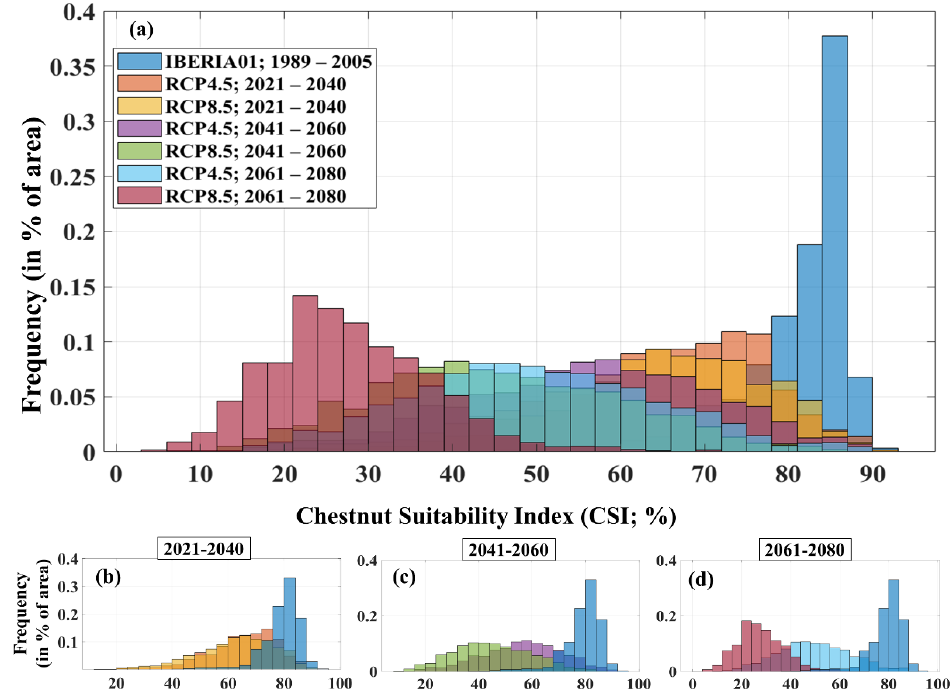
Figure 7. Relative distribution of chestnut areas (%) as a function of the CSI for ( a ) all periods (2021 – 2040; 2041 – 2060; 2061 – 2080), and each period separately ( b ) 2021 – 2040; ( c ) 2041 – 2060; ( d ) 2061 – 2080, under RCP4.5 and RCP8.5. In ( a ), the distribution for the baseline period is also shown (IBERIA01, 1989 – 2005).